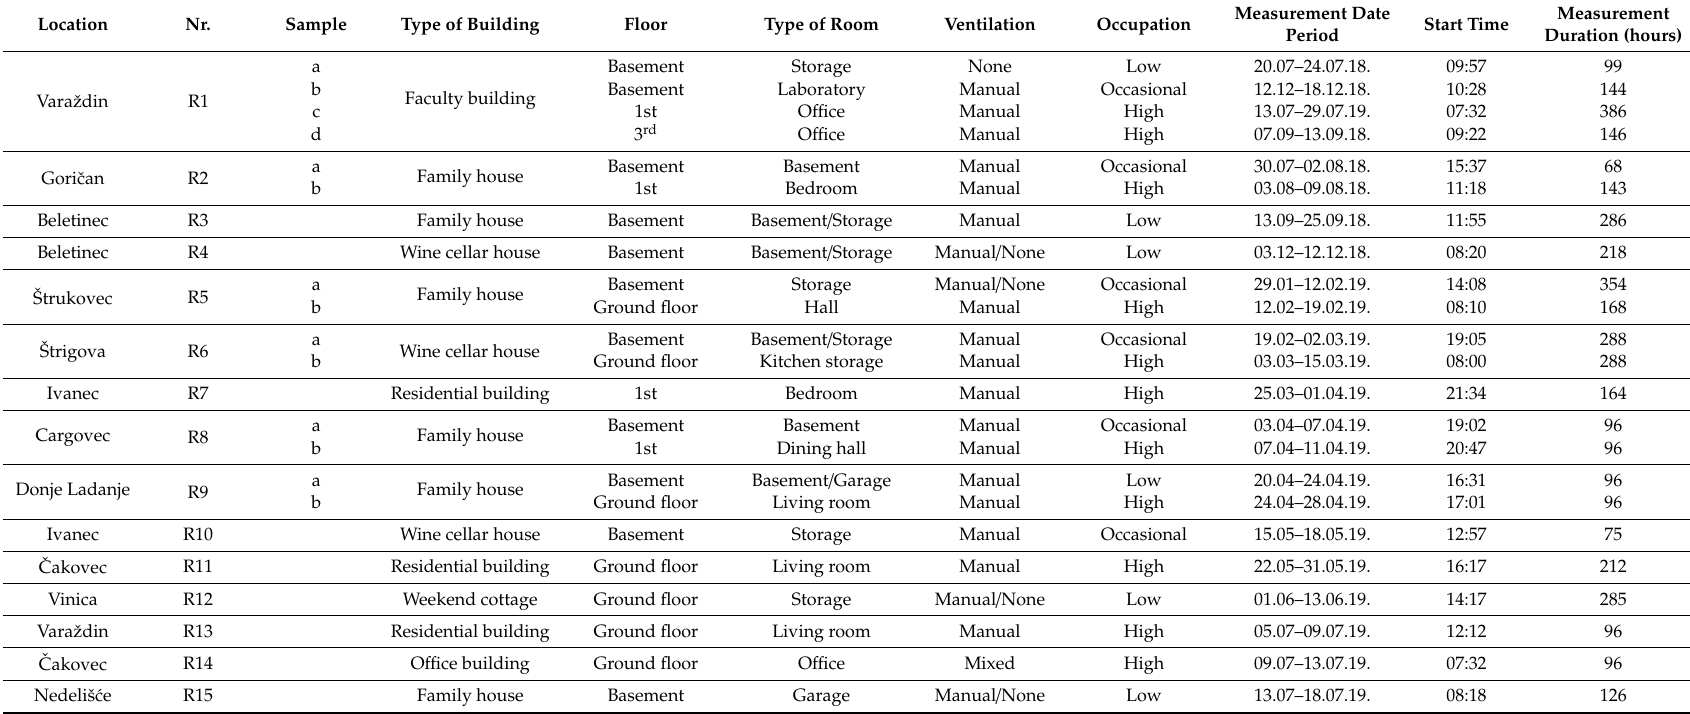
Table 1. Description of radon measurement locations for randomly selected buildings in Northern